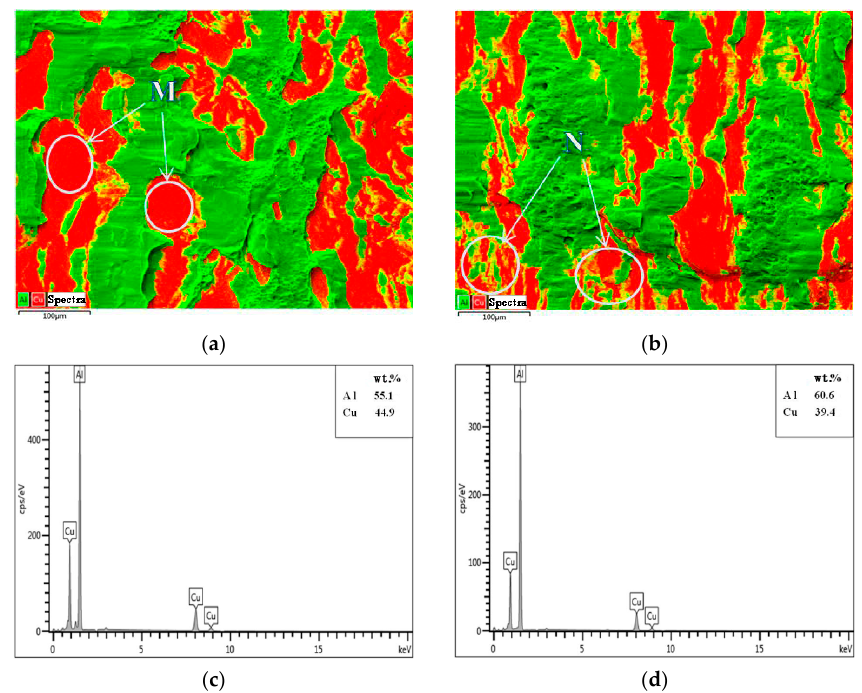
Figure 6. EDS spectra of the shear interface on the copper side: ( a ) unpulsed copper side element surface distribution; ( b ) pulse copper side element surface distribution; ( c ) proportion of the element surface distribution of unpulsed copper side; ( d ) proportion of the element surface distribution of pulse copper side.